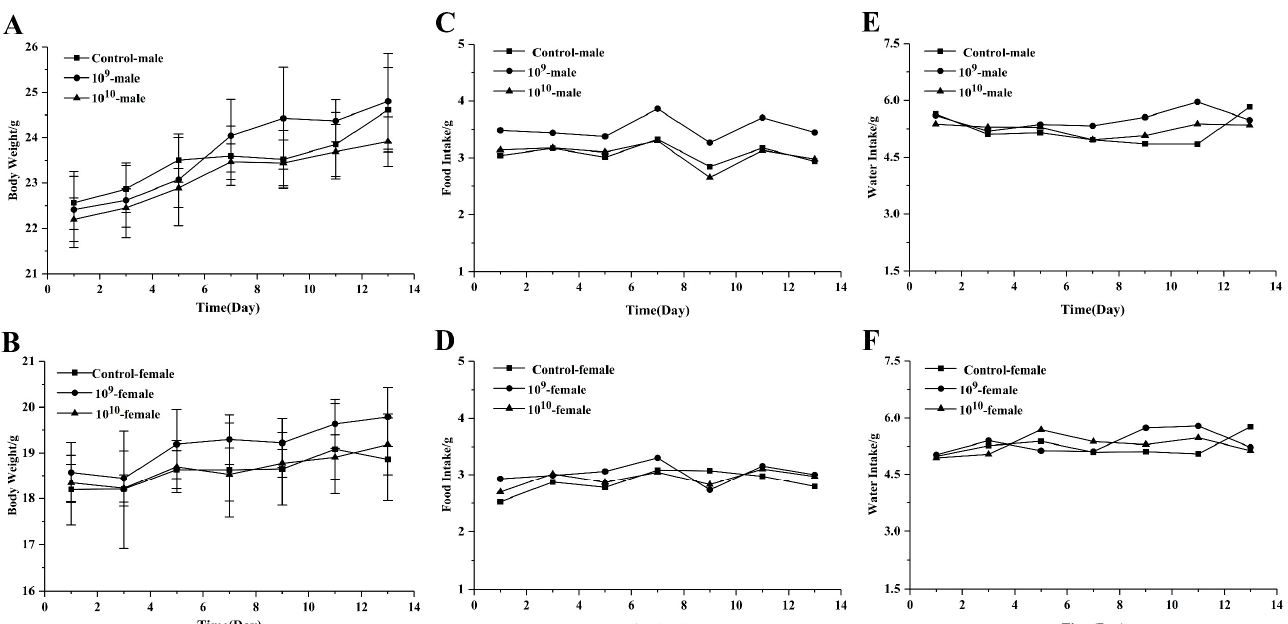
Figure 2. Effects of Blautia producta DSM 2950 on body weight and food and water intake. ( A ) Body weight of male mice. ( B ) Body weight of female mice. ( C ) Food intake of male mice. ( D ) Food intake of female mice. ( E ) Water intake of male mice. ( F ) Water intake of female mice.